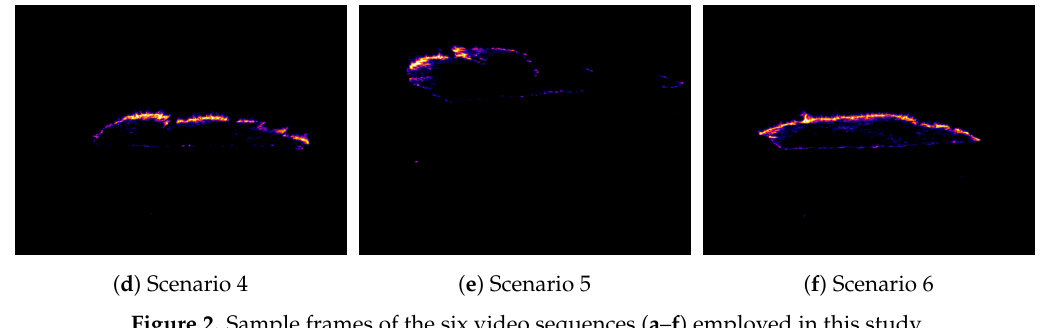
Figure 2. Sample frames of the six video sequences ( a – f ) employed in this study. Table 1. Camera properties and parameters used to record analyzed footage.